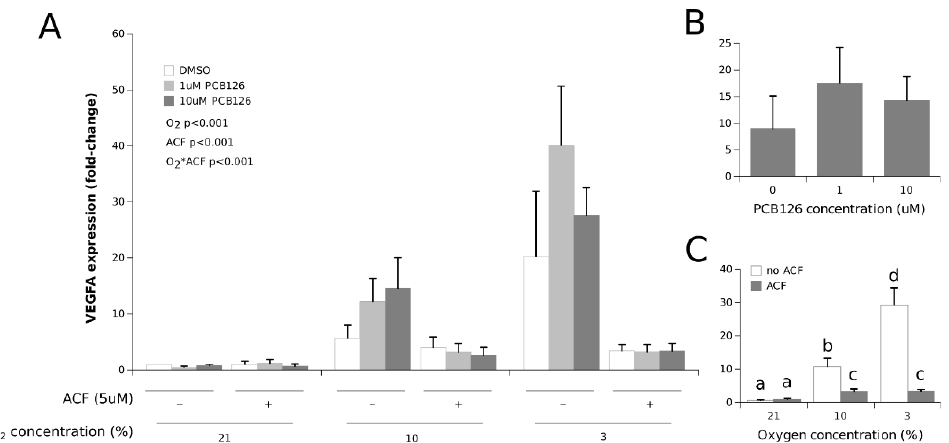
Figure 2. Effect of PCB126 and hypoxia on VEGFA expression in human adipocytes. Adipocytes were treated with DMSO (vector) or 1 and 10 µM PCB126 for 24 h, and then subjected to 21, 10 or 3% O 2 for another 24 h. Acriflavine (ACF) 5 µM was used as the HIF1 α -inhibitor. Panel ( A ) illustrates the whole model. Markers of statistical difference for individual bars were omitted due to the complexity of the model. Panel ( B ) summarizes the main effect of PCB126 on VEGFA expression. Panel ( C ) summarizes the effects of hypoxia and ACF treatment on VEGFA expression. In panel C, bars not sharing a common letter are statistically different at p < 0.05. Each bar represents the mean ± SEM of three separate experiments for each treatment group.